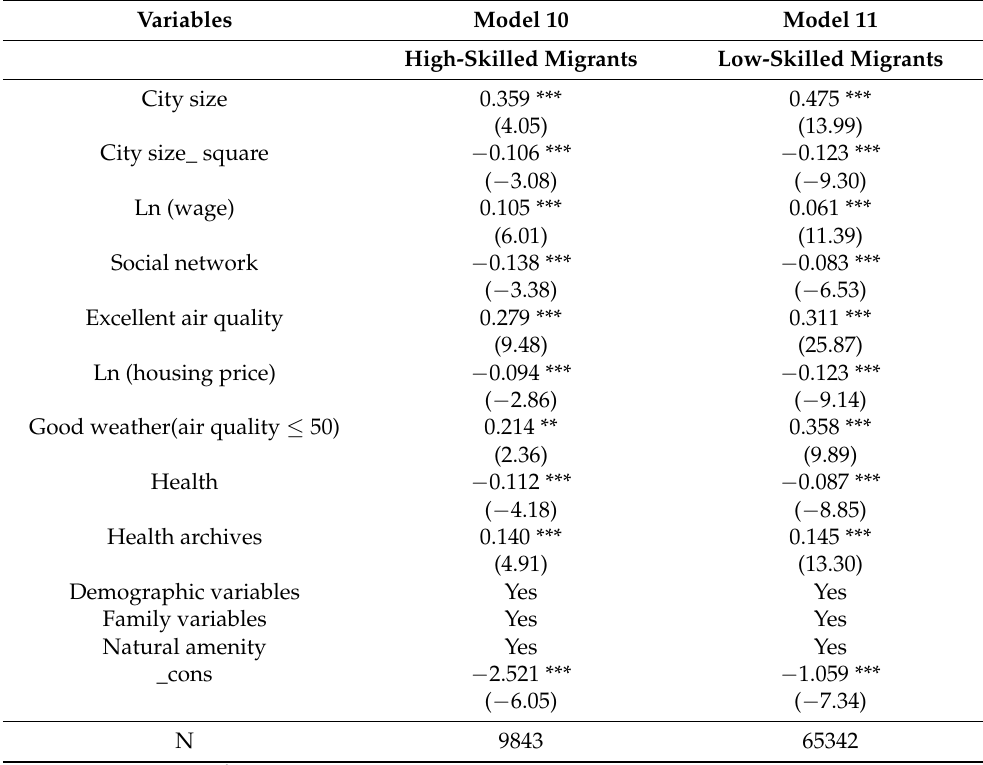
Table 6. The heterogeneity test of city size and settlement intention among high-low skilled